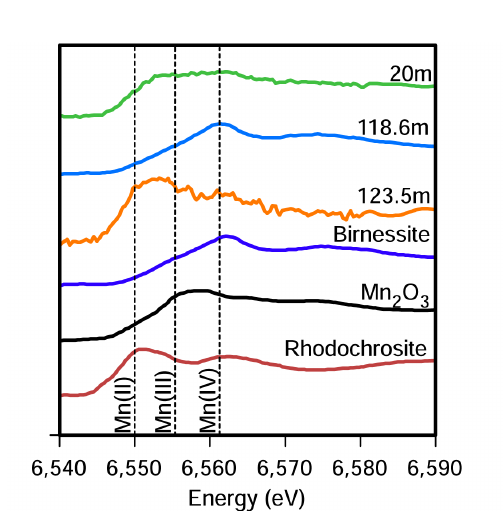
Fig. 4. Bulk XANES spectra of standards and water column parti- cles. Mn 2 O 3 spectra courtesy of Steve Heald at Argonne National Laboratory.